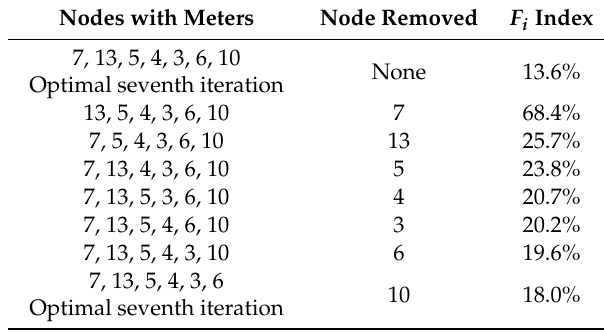
Figure 11. Branch power flow uncertainties obtained when one PM is removed from the seven-meter optimal condition found for the Vittorio Emanuele feeder. Table 5. Sensitivity index when one PM is removed from the seven-meter optimal condition found for the Vittorio Emanuele feeder.